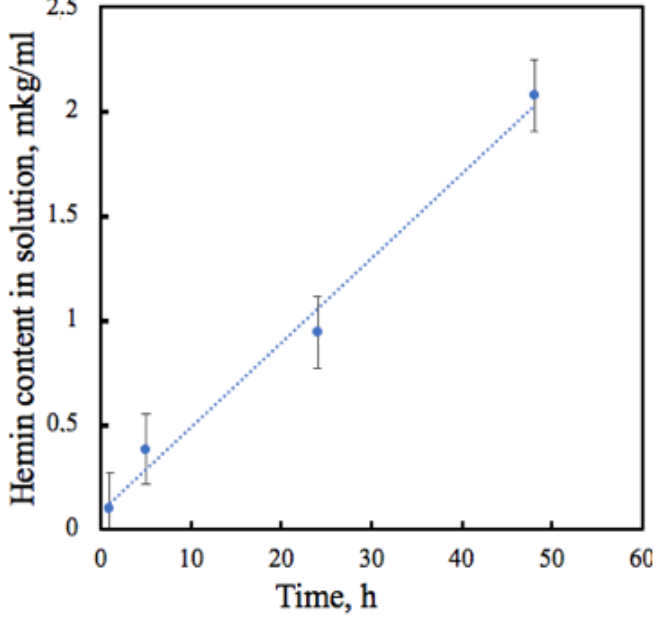
Figure 7. The changes in the Hmi concentration in PBS solution (pH 7.4, 37 ◦